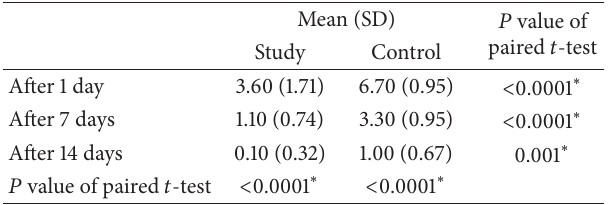
Table 1: Comparison of pain sensations between study and control at different follow-up periods.